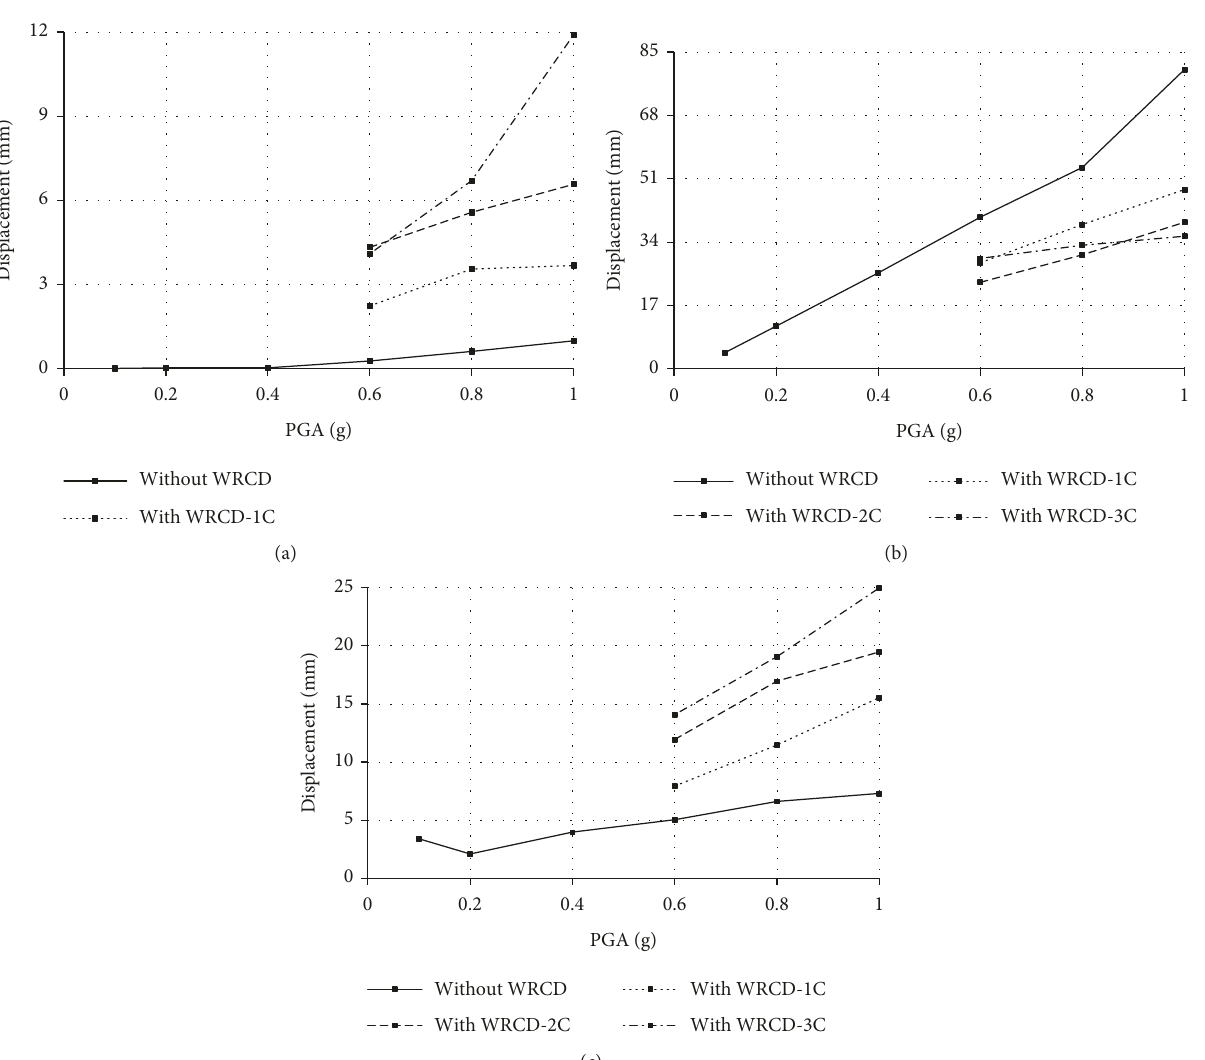
Figure 11: Displacement variation trend with seismic input intensity under Tianjin ground motion. (a) Top of movable pier #1. (b) the Main beam of pier #2. (c) Top of movable pier